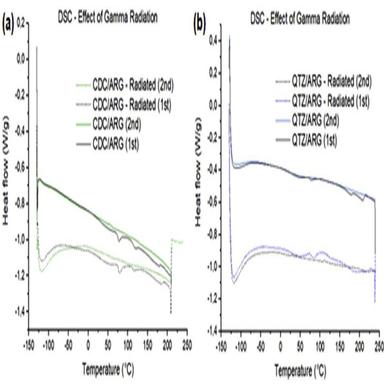
1st and 2nd heating steps of DSC scans before and after gamma radiation exposure of QTZ/ARG (left) and CDC/ARG (right).